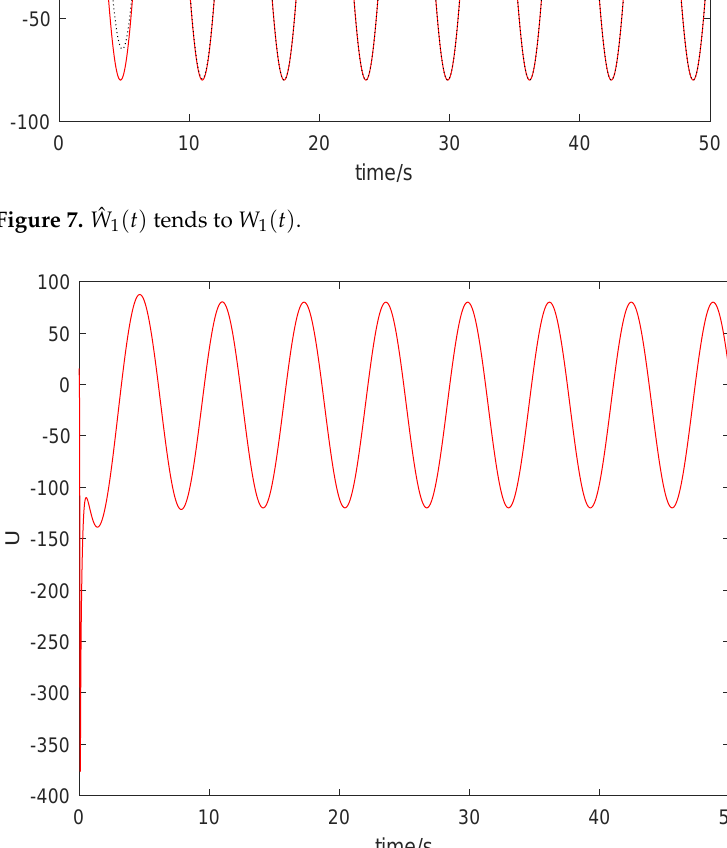
Figure 8. The state of control signal U ( t )